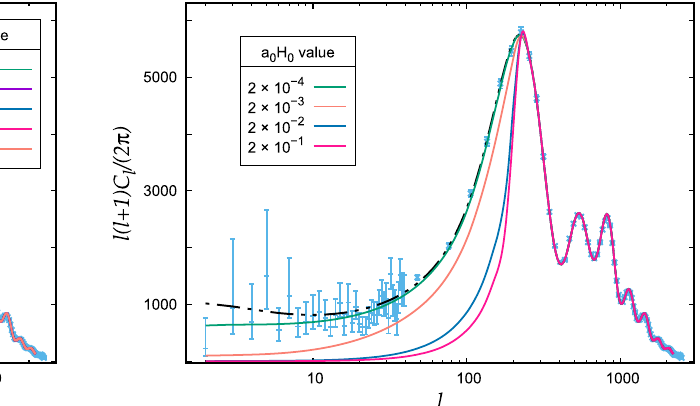
Fig. 4 Four different orders of magnitude corresponding to a 0 H 0 are explored, with fixed B = 10 − 4 (which has shown good compatibility with data). The highest values show a strong suppression in the angular power spectrum not compatible with observational data. This indicates that a 0 H 0 plays the role of a free parameter and could be estimated with statistical analysis. Dashed black line represents the canonical model . Planck’s data are shown in blue points along with their error